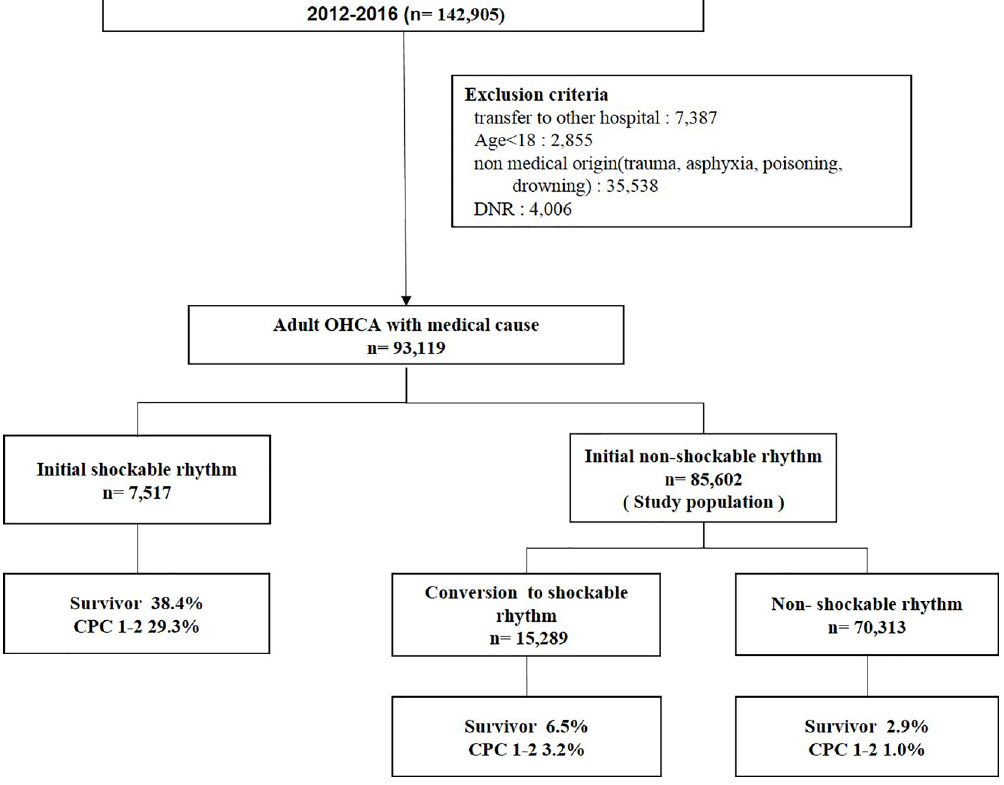
Figure 1. Study population and clinical outcome. OHCA, out-of-hospital cardiac arrest; KCDC, Korea Centers for Disease Control and Prevention; DNR, do not resuscitate; ED, emergency department; CPC, cerebral performance category.